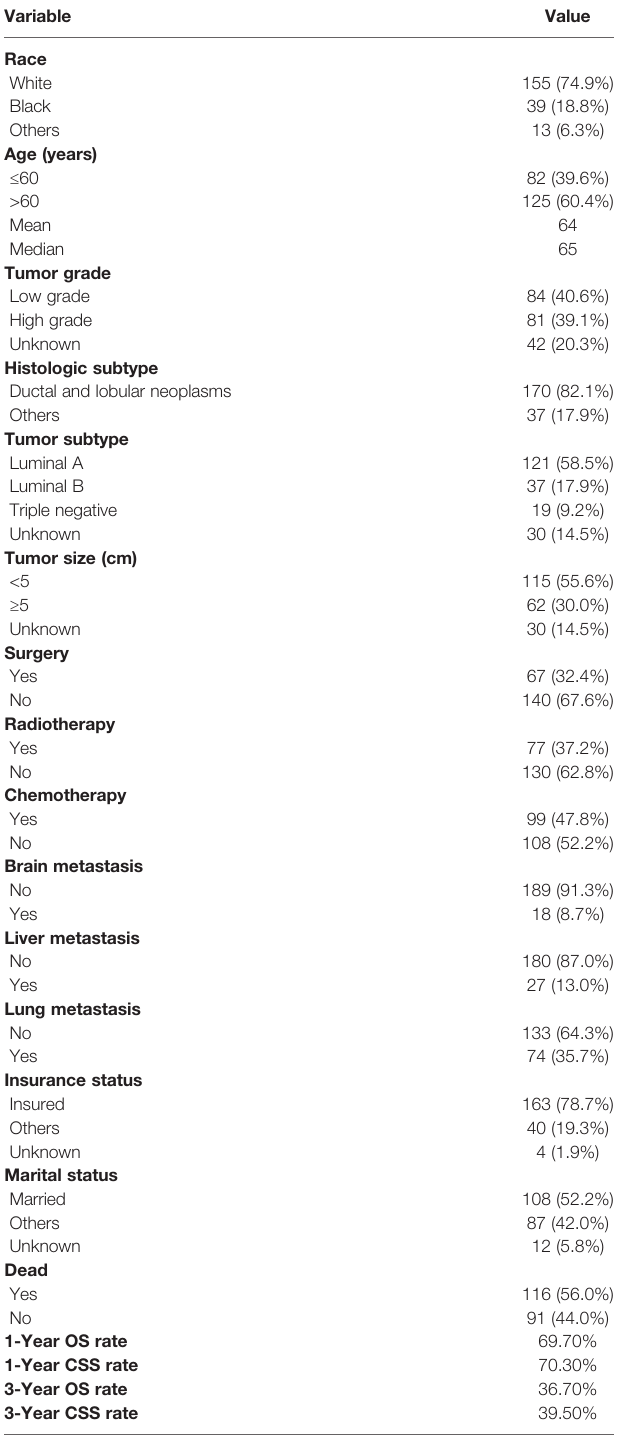
TABLE 1 | Baseline characteristics of 207 male breast cancer with bone